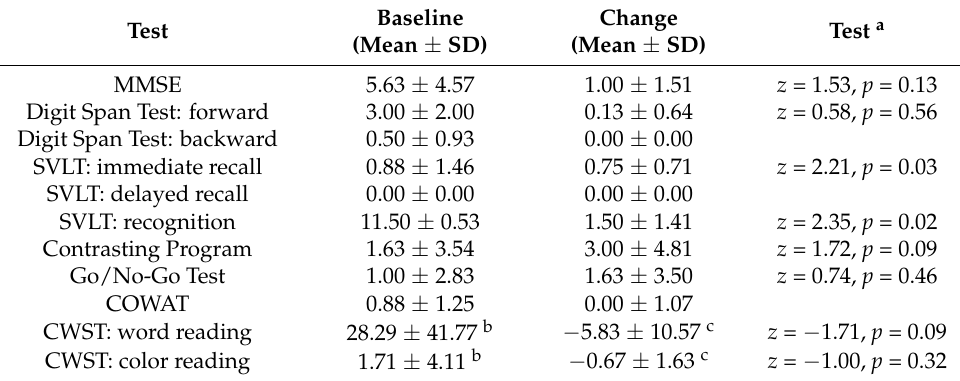
Table 2. Changes in neuropsychological test results after transcranial focused ultrasound.